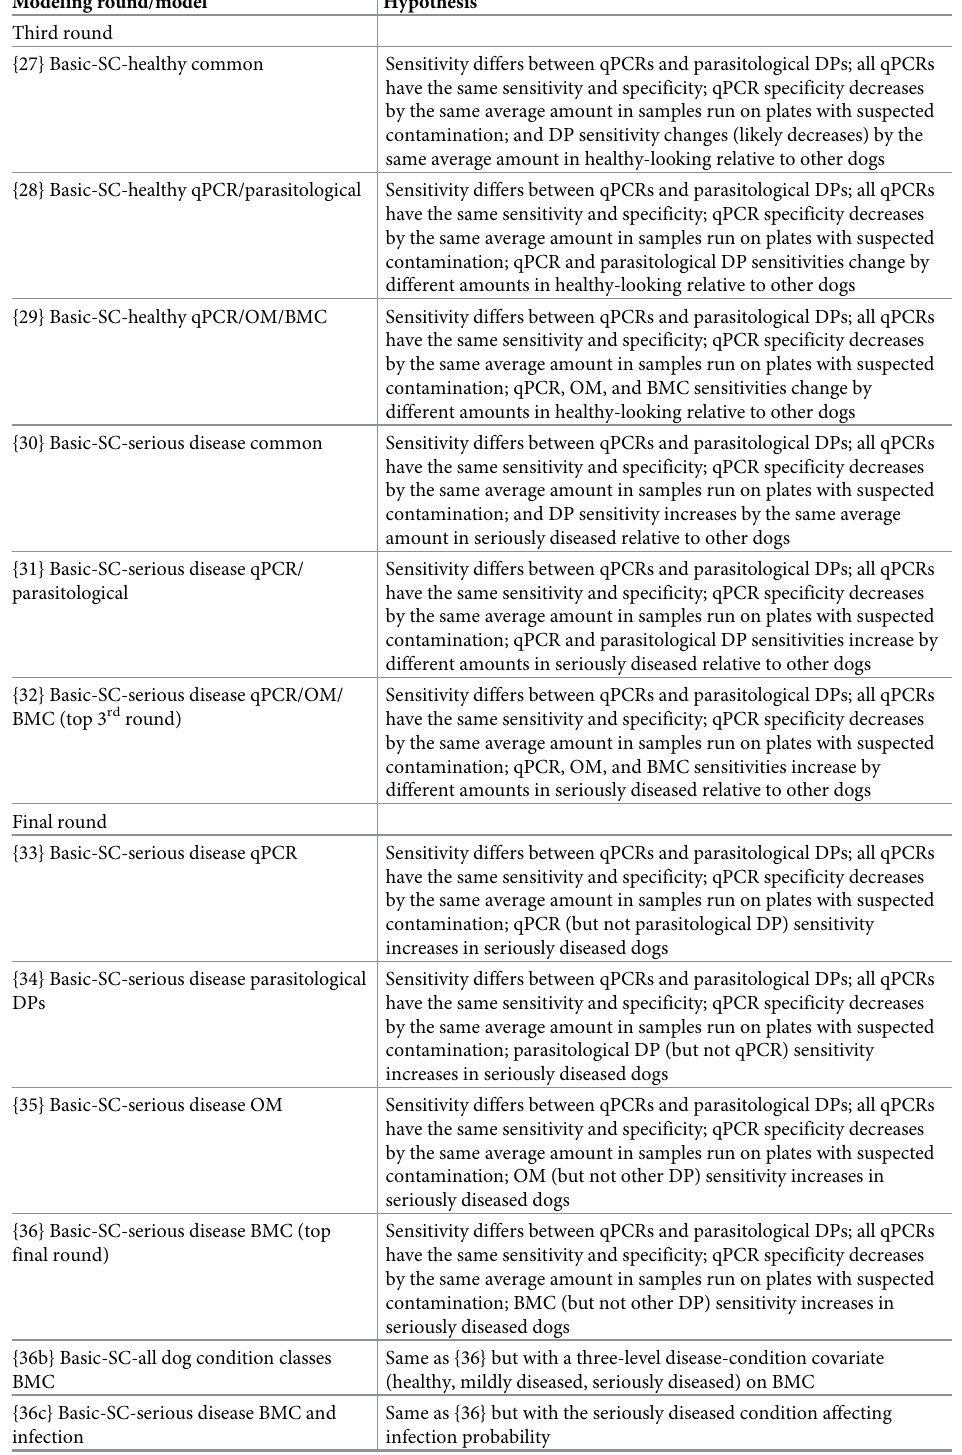
Table 3. Influence of dog clinical status on the performance of diagnostic procedures (DPs) for detecting Leish- mania : Models and associated